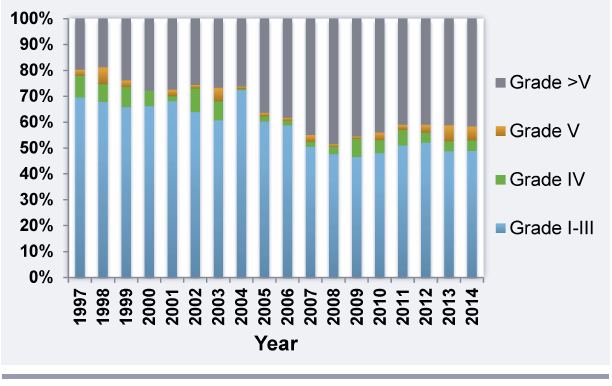
Fig. 7 . Dynamics of surface water quality from 1997 to